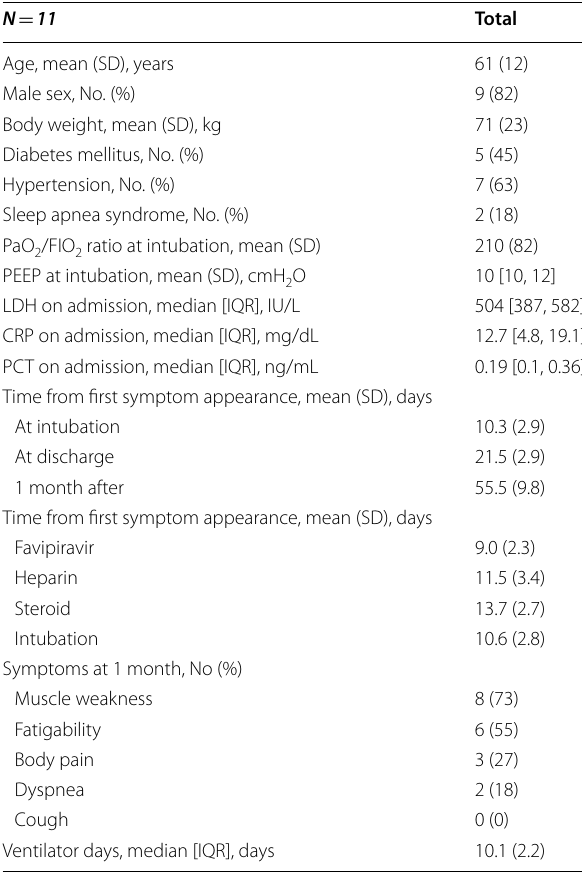
Table 1 Characteristics of the 11 patients with